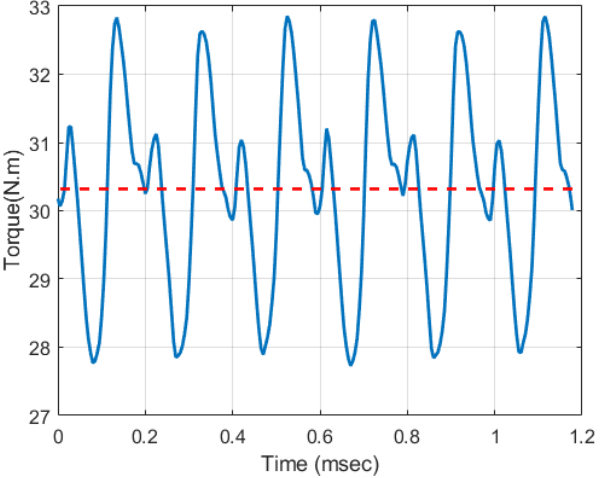
Figure 4. Output torque (in blue) and its average value (in red) obtained via FE analysis.